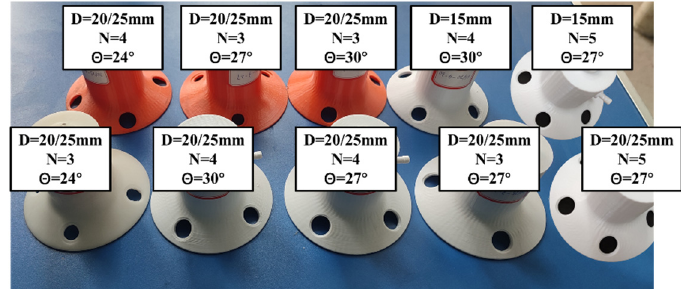
Figure 31. Part of the suction cup layout structure.